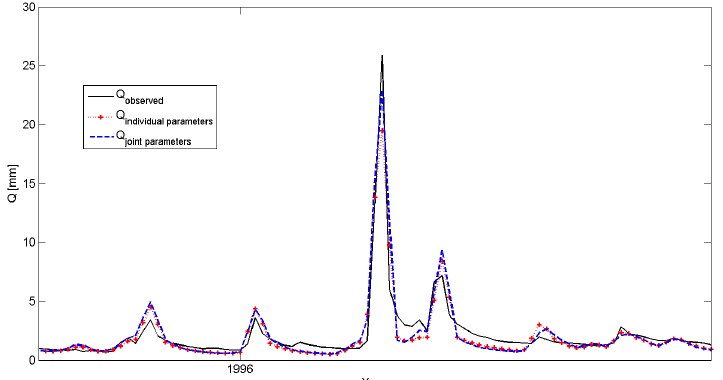
Figure 9. Runoff hydrographs for catchment 5 obtained using individual and leave-one-out common calibrations of HBV using the NS performance